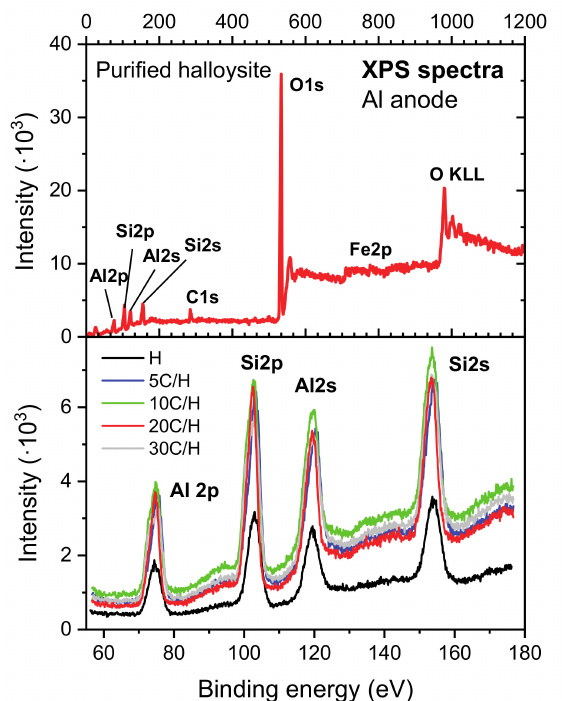
Figure 1. Survey XPS spectrum (top panel) of the purified halloysite sample (H). In the spectrum, O, C, Si, Al, and Fe lines were identified. In the bottom panel narrow scans of the Al2p, Si2p, Al2s, Si2s, peaks are presented. The spectra were not normalized to adventitious carbon C-C peak position (check discussion in the